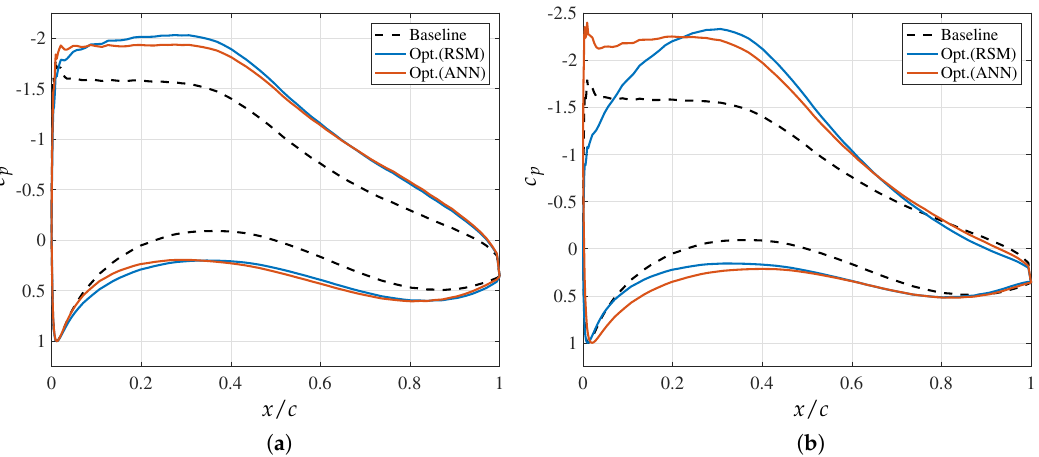
Figure 8. The pressure coefficient graphs for the optimal wind turbine designs. The graphs in ( a , b ) show the pressure coefficients of the airfoils presented in Figure 7a,b,